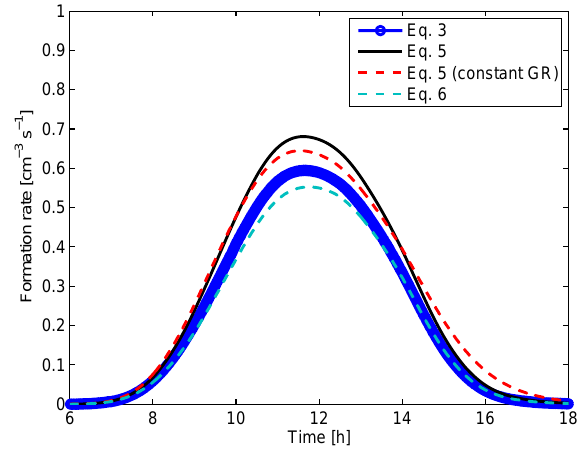
Fig. 2. The simulated particle size distribution data used in the anal- ysis.